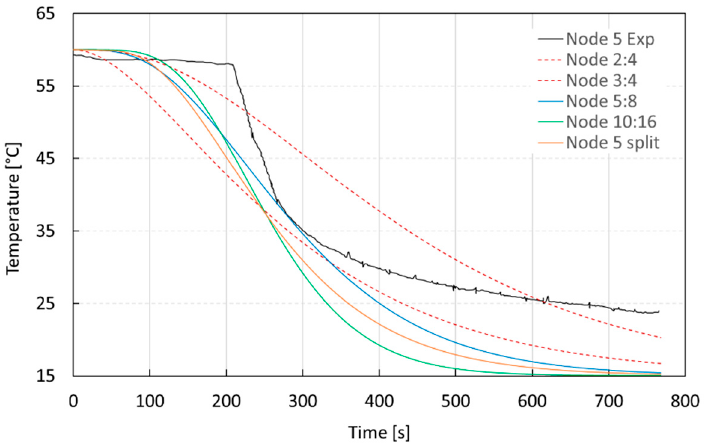
Figure 21. Experimental temperature evolution at node #5 vs. simulation results—10 dm 3 / min volume flow rate—discharge phase.